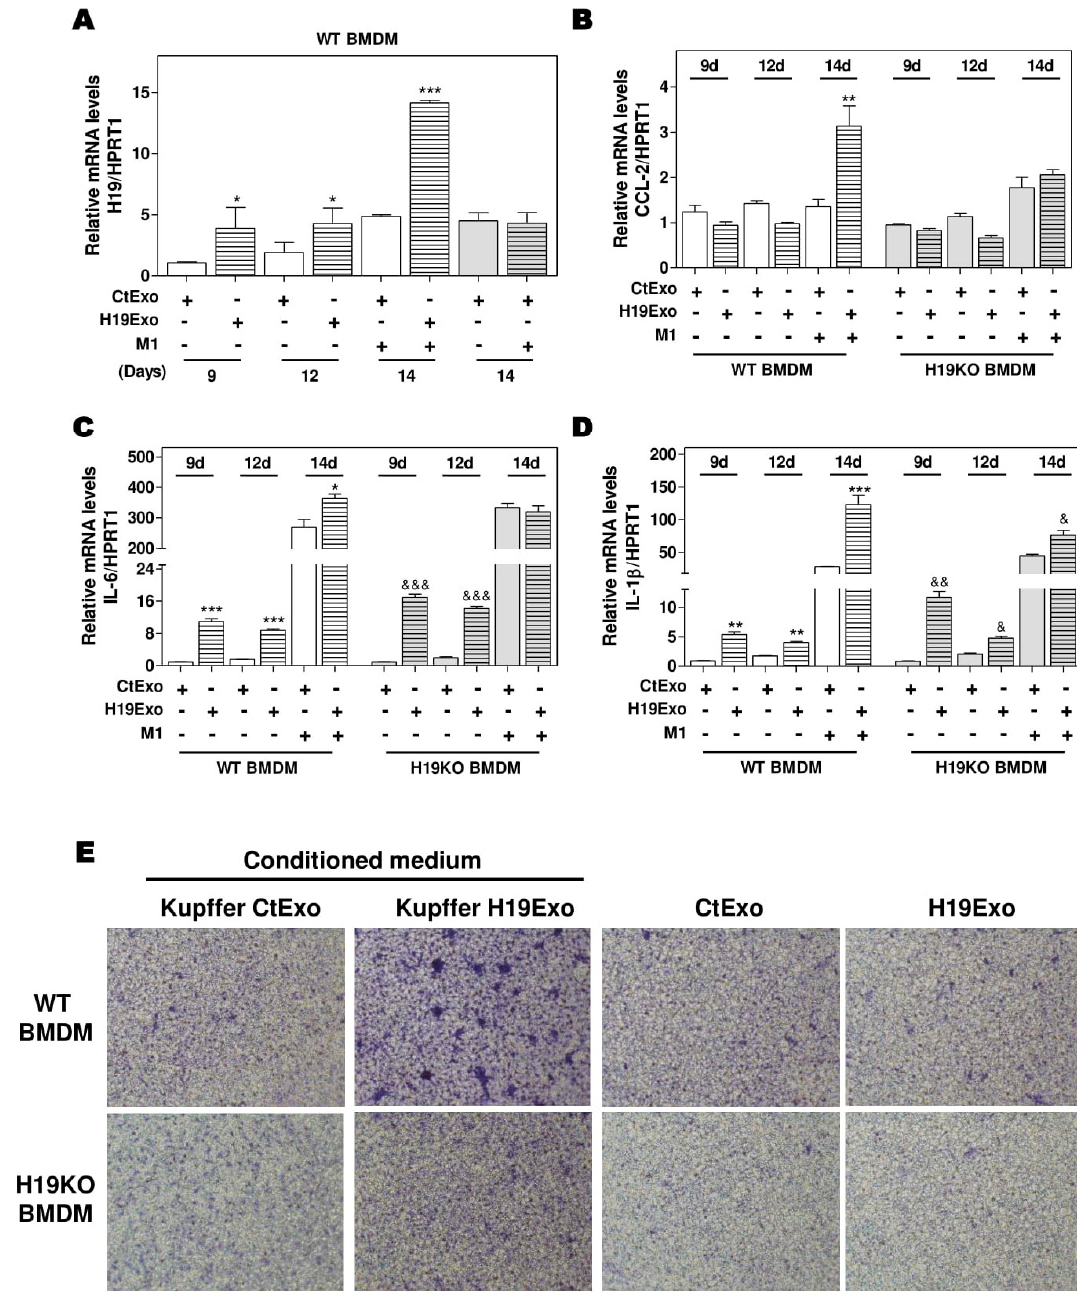
Figure 3. Cholangiocyte-derived exosomal H19 promotes BMDM differentiation and macrophage migration. ( A – D ) Mouse BMDM cells were isolated and cultured for 7 days. BMDMs were then